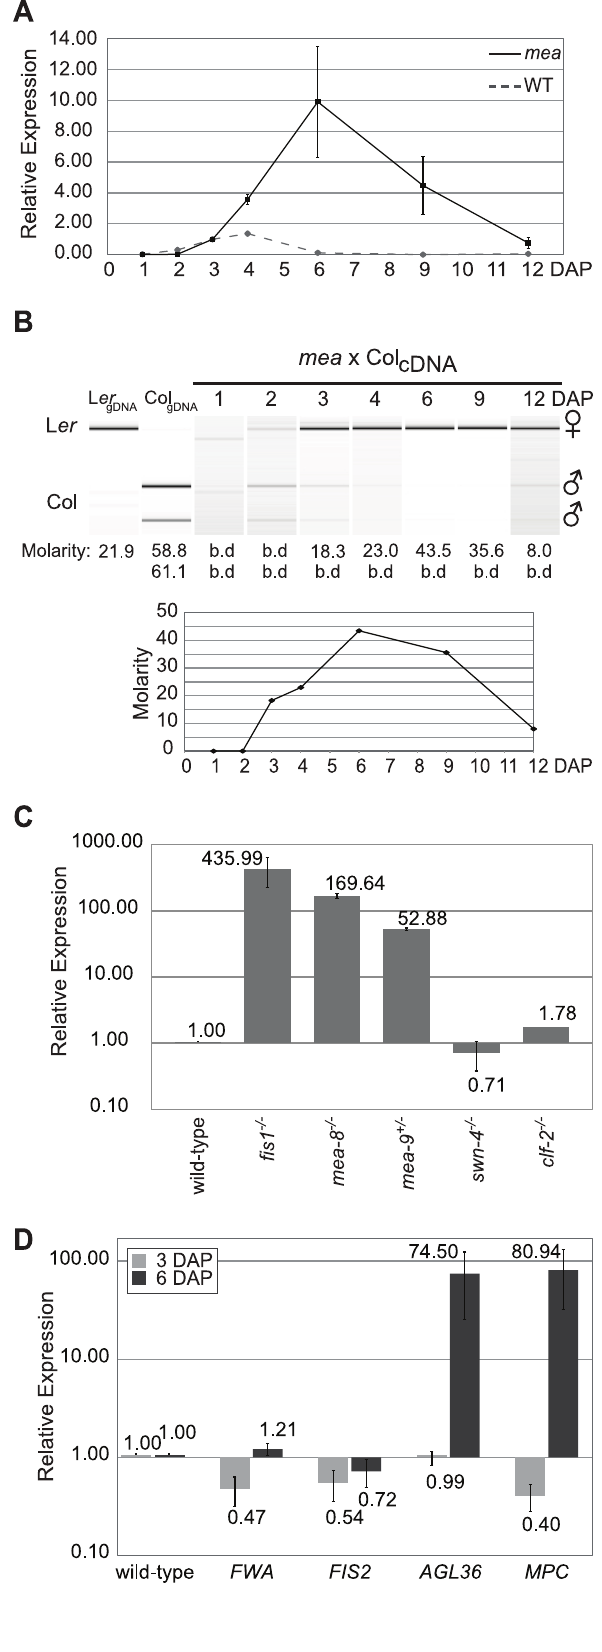
Figure 7. The maternal AGL36 allele is regulated by the PRC2 FIS-complex. (A) Real-time PCR AGL36 expression profile in 1–12 DAP wild-type and mea mutant seeds. 3 DAP values were used as the reference point for calculations. Samples were taken at indicated time points. The graph represents average expression obtained from two BRs and subsequent two TRs. STDEVs are derived from biological parallels. ACT11 is the reference gene used. (B) The FIS-complex regulates the maternal allele of AGL36 . The PCR product of AGL36 SNP region obtained from mea x Col fertilized seeds was Alw NI digested and analyzed. Genomic L er and Col DNA were included as controls. The intensities of the represented bands (nmol/L), allows comparison between different time-points. Note, unsustainable weak paternal signals at 2 and 3 DAP are below the detection limit for measurement on our instrument (0.1 ng/ m l , 0.4 nmol/L) and indicated as b.d. The chart represents the obtained concentrations from each sample. The displayed SNP picture is representing one of four different runs (2BRs and 2TRs). (C) AGL36 is regulated in three different alleles of mea but not in the E(z) MEA paralogues, clf and swn. Real-time PCR analysis showing AGL36 expression in ( mea ) fis1 2 / 2 , mea-8 2 / 2 , mea-9 + / 2 , swn- 4 + / 2 and clf-2 2 / 2 compared to wild-type. STDEVs are derived from two independent BRs. ACT11 is the reference gene used. (D) Real-time PCR expression level of FWA , FIS2 , AGL36 and MPC in mea-9 x Col vs. wild- type seeds 3 and 6 DAP. Graphs represent the average relative expression values obtained from four independent BRs. Samples used in the first biological parallel gave rise to two TRs. STDEVs are derived from the independent BRs. The transcript levels were normalized to ACT11